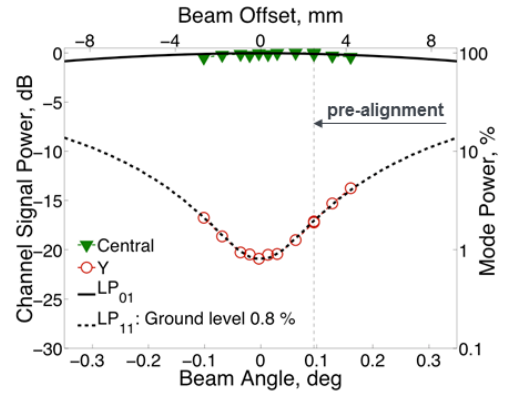
Figure 8. Measured signals and theoretical predictions for a sim- ple interferometer setup. Beam o ff set and angle are coupled in this